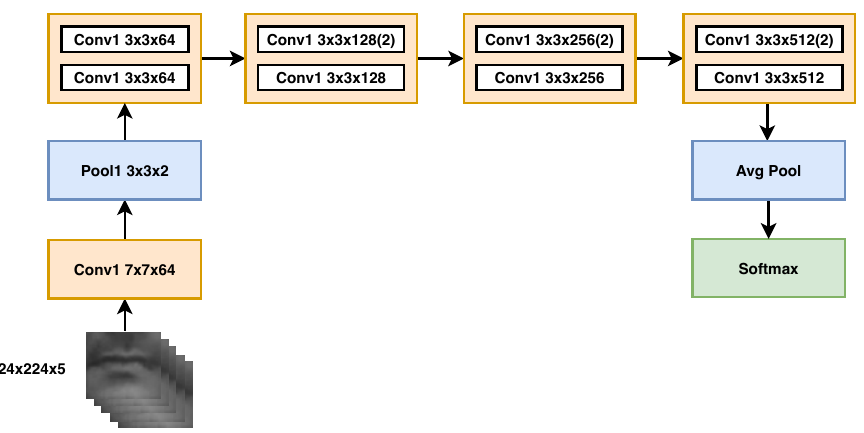
Figure 9. DNN (ResNet) architecture for lip-reading.